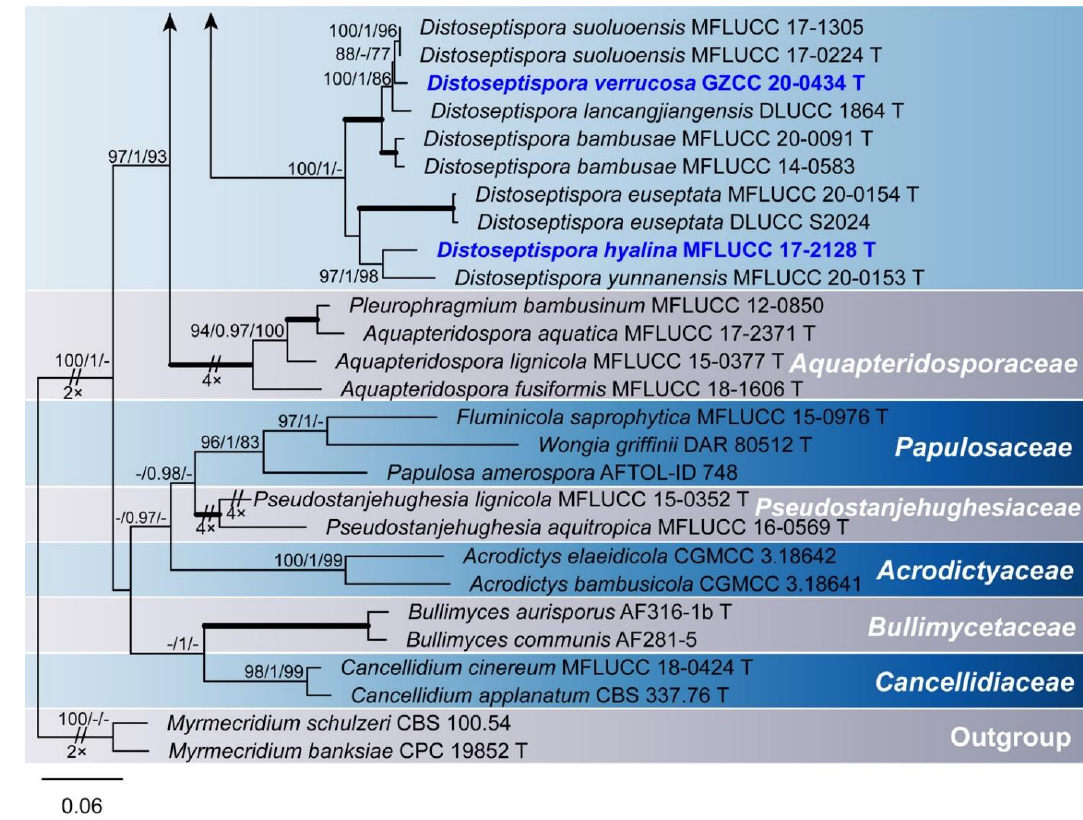
Figure 1. Maximum likelihood majority rule consensus tree for Distoseptisporaceae and related families using LSU, ITS, TEF1 α , and RPB2 sequence data. Bootstrap support values for maximum likelihood (ML) and maximum parsimony (MP) greater than 70% and Bayesian posterior probabilities greater than 0.90 are indicated above branches as ML BS/PP/MP BS. The scale bar represents the expected number of changes per site. The tree is rooted with Myrmecridium schulzeri (CBS 100.54) and Myrmecridium banksiae (CPC 19852). Ex-type strains are indicated with T. The new collections are in bold with new taxa in blue. Branches with 100% ML BS, 1.0 PP, and 100% MP BS are thickened. Families are indicated as colored blocks.